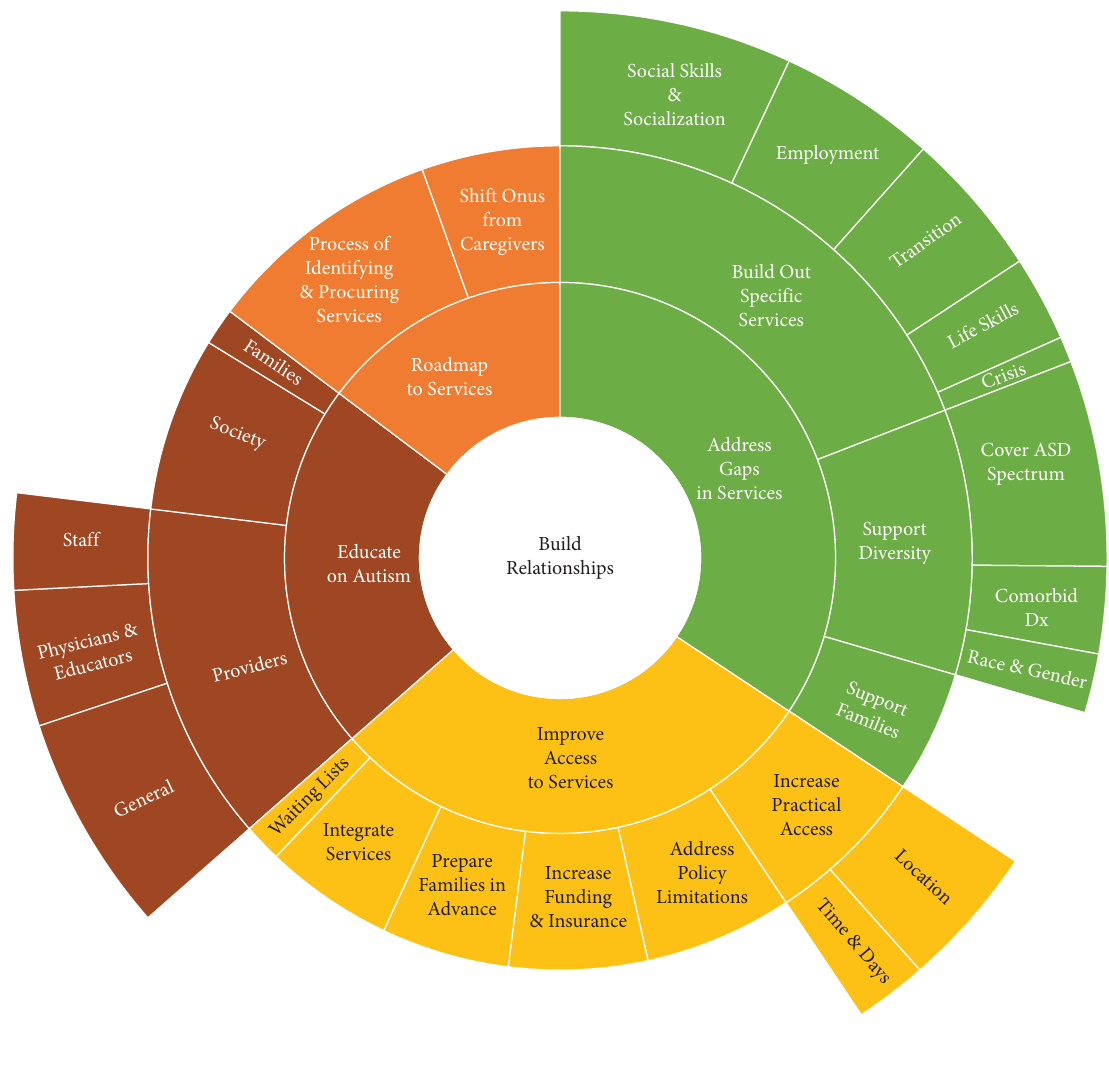
Figure 1: Findings from refexive thematic analysis of caregivers’ advice to service providers. Note. ASD: autism spectrum disorder; Dx: diagnoses; Tx: